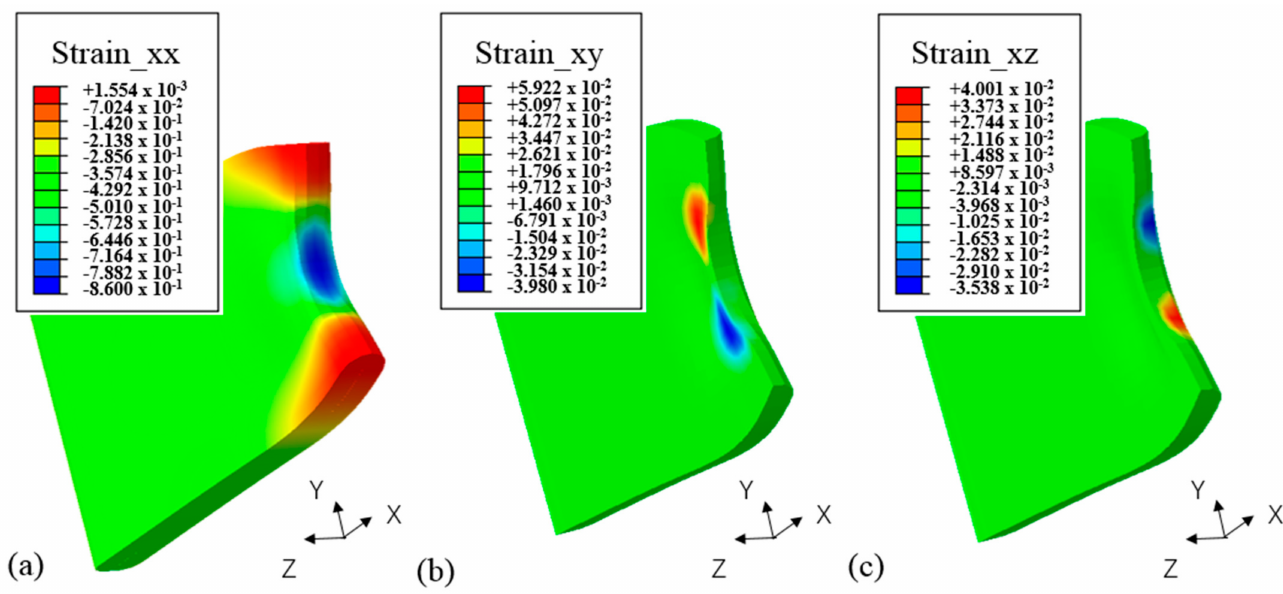
Figure 11. Component of strain during indentation simulation along X direction: ( a ) X component; ( b ) XY component; ( c ) XZ component. (Half of the jellyroll is shown in ( b , c